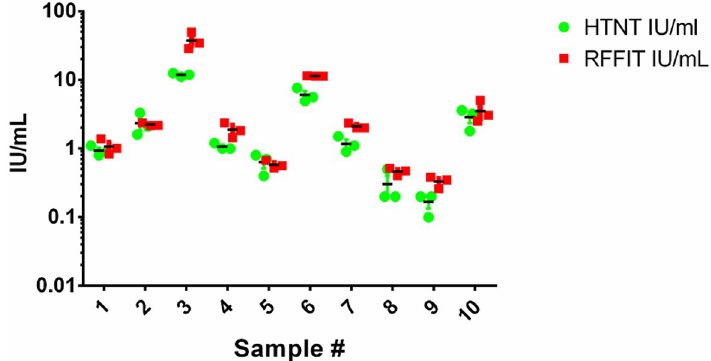
positive samples are plotted to evaluate the inter-assay variability.